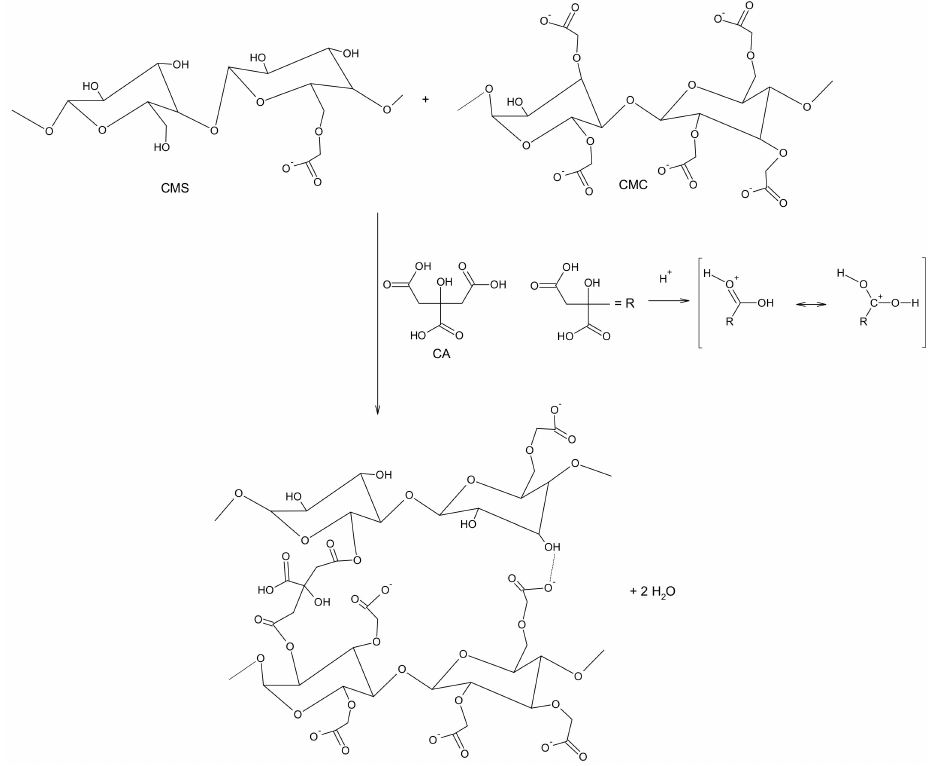
Figure 2. Scheme of CMS / CMC crosslinking reaction with citric acid (CA), for the sake of clarity the reaction for molar ratio equal 1.0 was